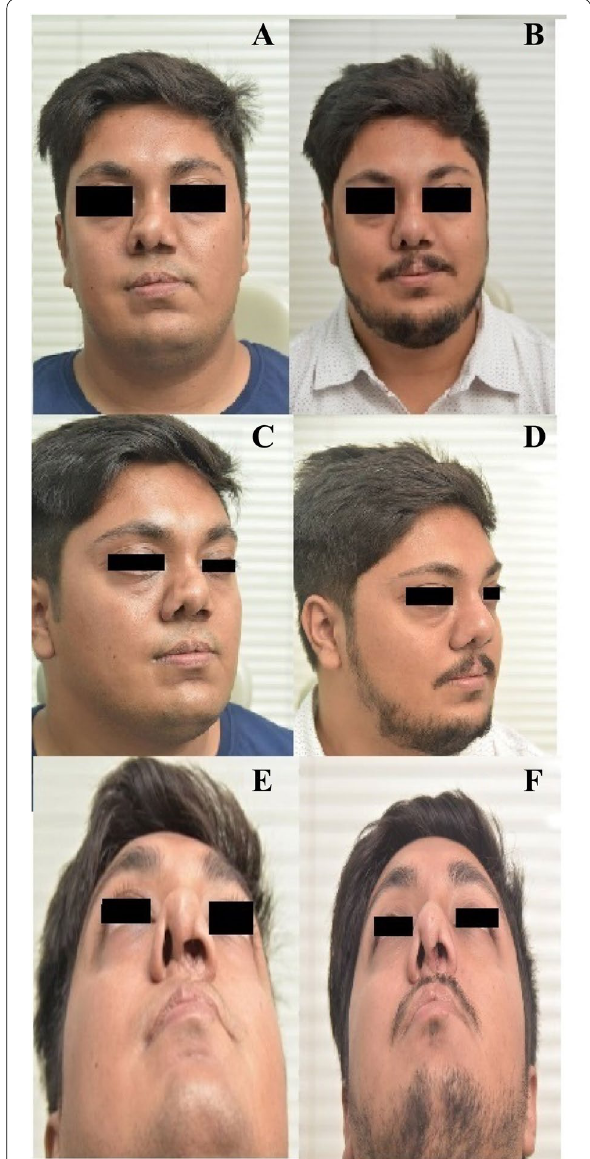
Fig. 7 Comparative pre- and post-operative pictures at 2 years follow-up. A Preoperative frontal view. B Postoperative frontal view. C Pre-operative left oblique view. D Post operative left oblique view. E Preoperative basal view. F Postoperative basal